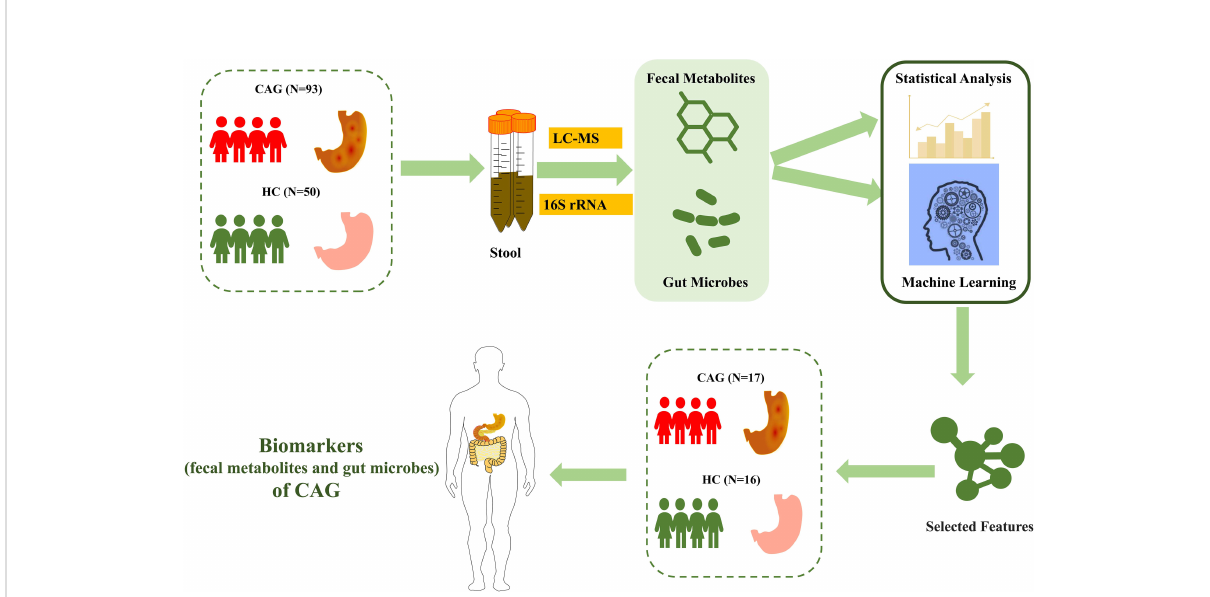
FIGURE 1 Study design and population. After pathological diagnosis and exclusion process, a total of 176 fecal samples (110 patients with CAG and 66 healthy controls) from Shanghai University of TCM af fi liated Shuguang Hospital were prospectively collected. We divided into the discovery phase and validation phase. In the discovery phase, we characterized fecal metabolites among A sample set (30 healthy controls and 48 CAG patients) and gut microbiome among B sample set (20 healthy controls and 45 CAG patients). Furthermore, we identi fi ed the markers of gut microbiome and fecal metabolites to construct CAG classi fi er by random forest model from A sample set and B sample set, respectively. In validation phase, we constructed CAG classi fi cation model using 7 fecal metabolites or 4 gut microbes, or 7 fecal metabolites with 4 gut microbes, respectively, on the C sample set (16 healthy controls, 17 CAG patients) to validate diagnosis ef fi